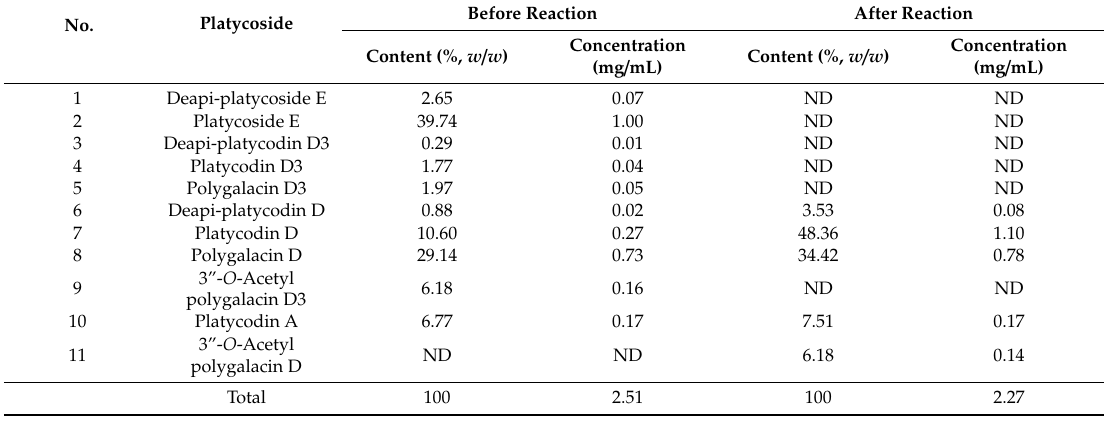
Table 2. Content of platycosides in 7.4% ( w / v ) Platycodi radix extract before and after deglucosylation by C. bescii β -glucosidase.